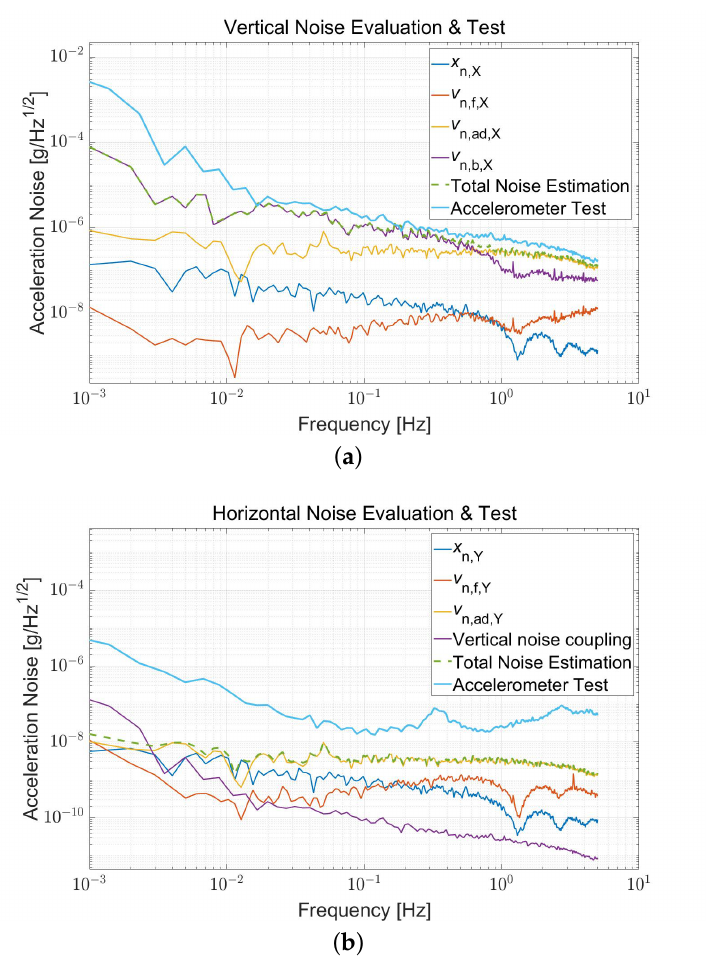
Figure 8. Total noise of the accelerometer estimation and test in the ( a ) Vertical and ( b ) Horizontal directions. By separately testing the noise of the sensing (Blue), high voltage feedback (Orange), ADC (Yellow), and polarization ( a ) or coupling noise ( b ) (Purple), the accelerometer noise floor (Green dashed line) is estimated according to (11). The prototype is tested to obtain its total noise (Light blue). The characteristic peaks of the seismic background are observed in the horizontal